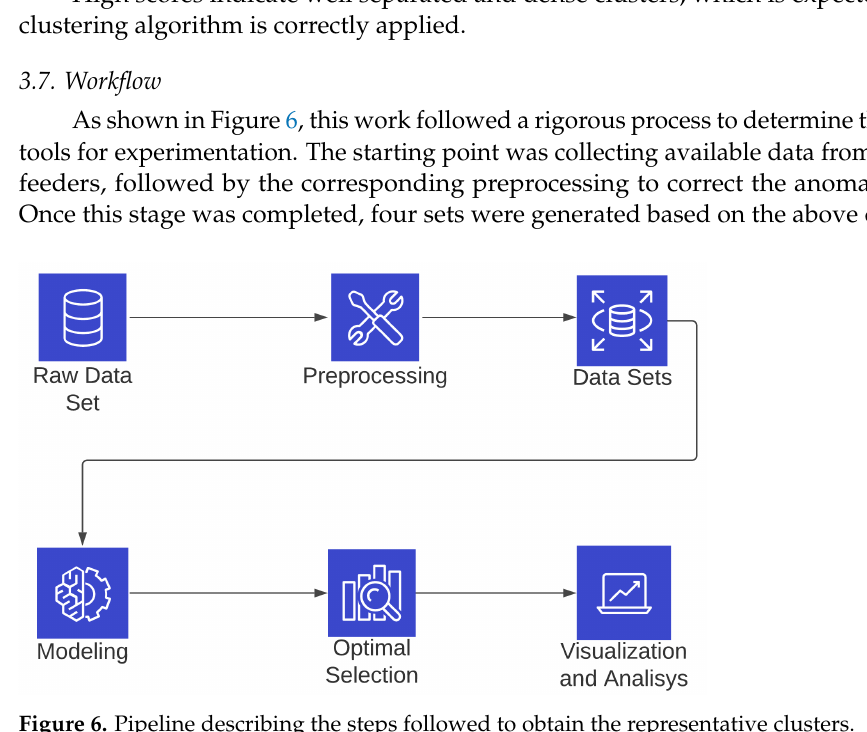
Figure 6. Pipeline describing the steps followed to obtain the representative